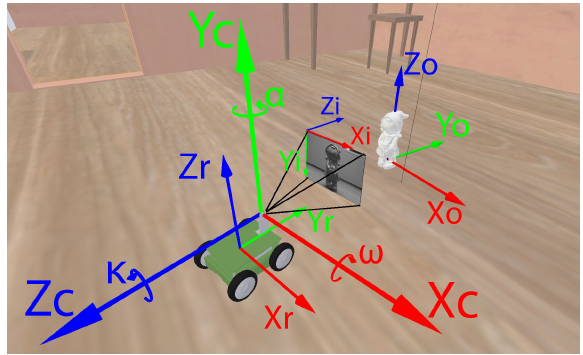
Figure 3. Coordinate systems: four coordinate systems are defined (left) to provide a common coordinate systems for 3D model of the scene and motion capture system